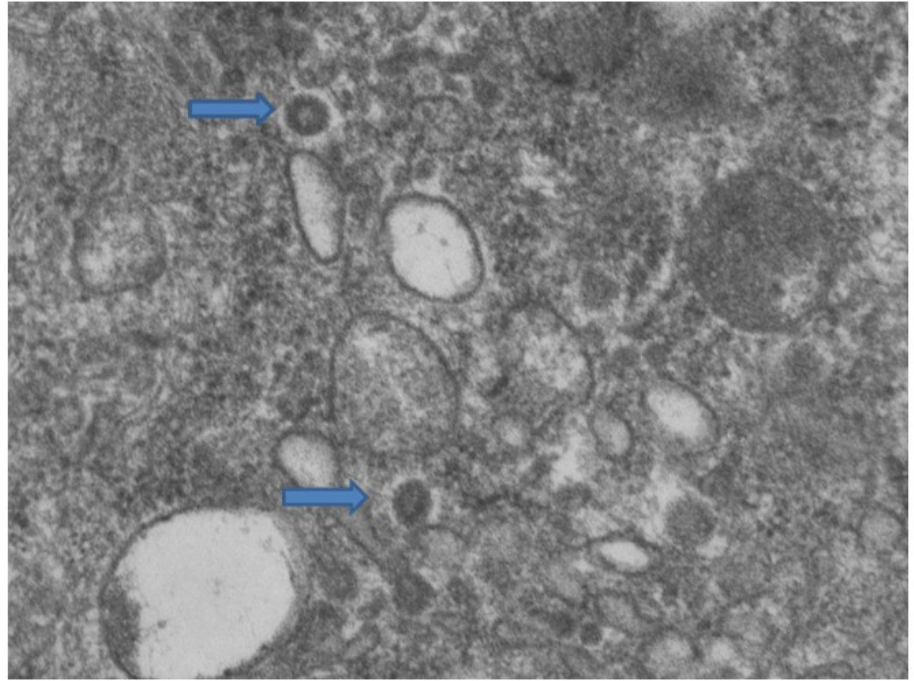
Figure 4. Cytoplasm of eccrine sweat glands. Among the cellular organelles (mitochondria and endoplasmic reticulum) the presence of two virions is observed, indicated by arrows (Electron microscopy, Original Magnification: 44,000 ×).